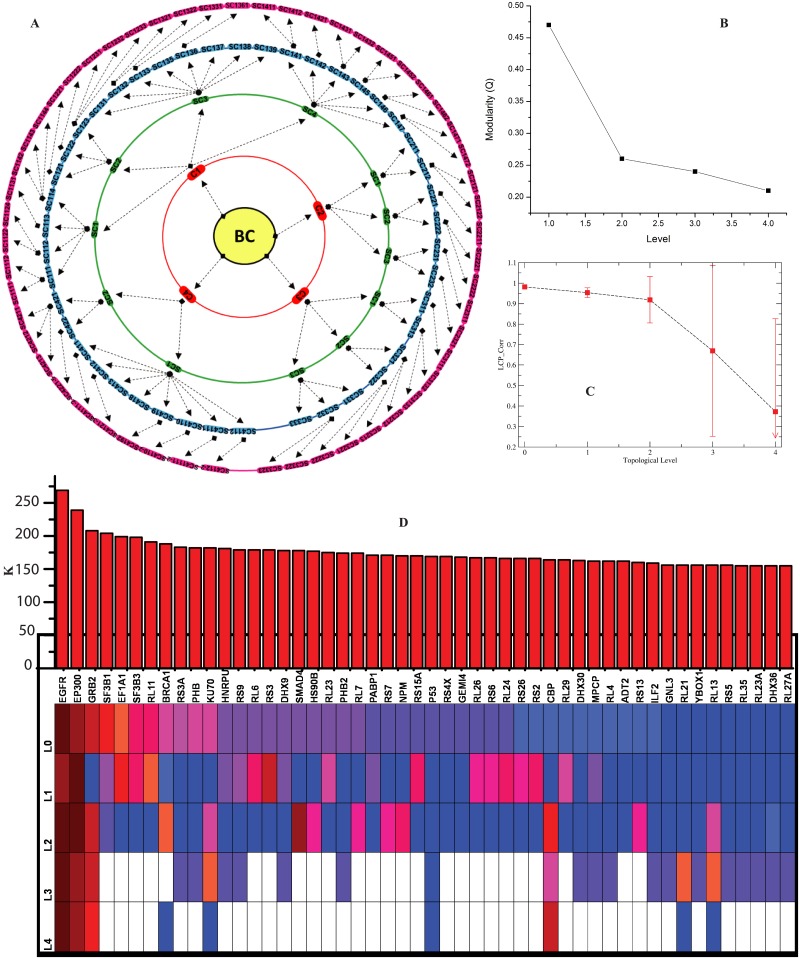
System level organization of breast cancer network.(a) Organization of modules/sub-modules at various levels (indicated by various concentric circles) and arrows show sub-modules constructed from previous modules. (b) Plots of modularity and LCP-correlation per node as a function of level of organization. (c) Popularity rankings of the first fifty leading hubs in the complete network: the plot also shows unpredictability of the these hubs at various levels of organization. Identification of key regulators of breast cancer network.